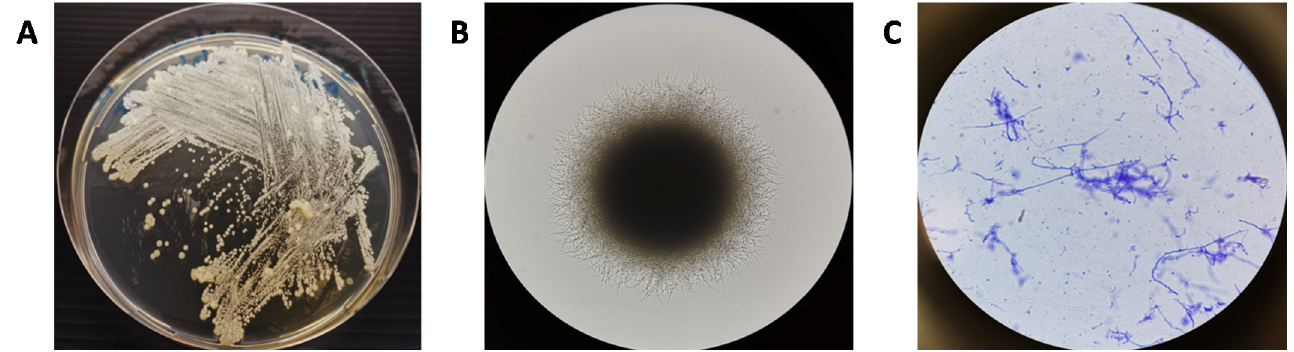
Figure 3. Visual images of the strain Actinomadura sp. ( A ) Macroscopic plate image. ( B ) Colony morphology on agar plate (100× magnification). ( C ) Cell morphology by Gram stain on glass slide (1000× magnification).